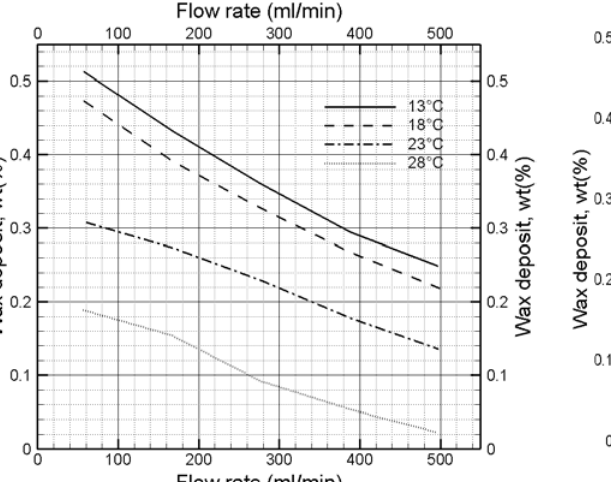
Figure 12 Effect of flow rate on deposited wax percentage at 12 min (Kelechukwu et al.,